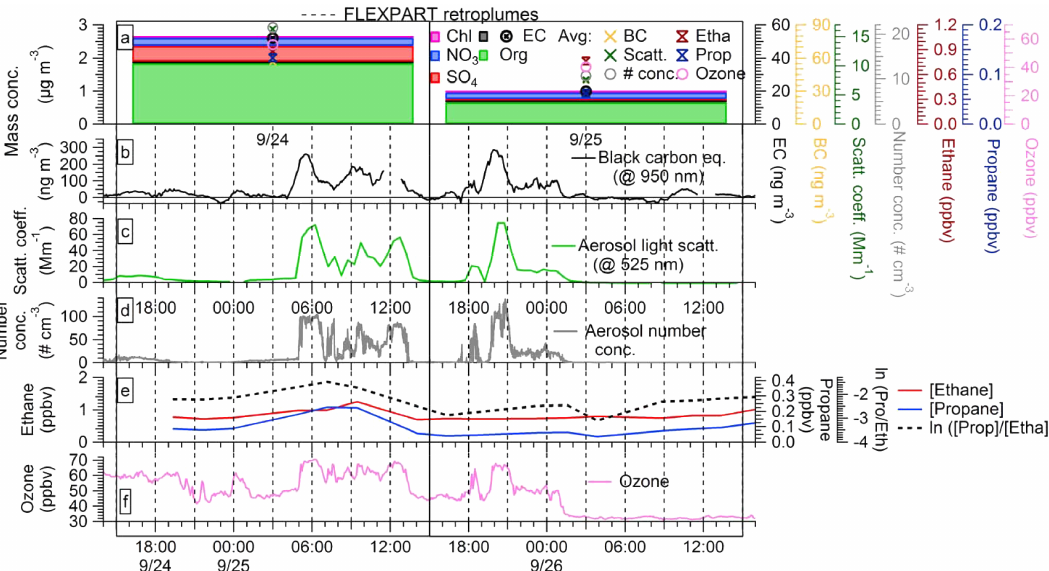
Figure 3. Comparison of aerosol measurements (a–d) during the 24–26 September case study with gas-phase measurements of ethane, propane (e) and ozone (f) . On-line measurements are also averaged during the filter-sampling periods (a) . Marked within the figure are the times of filter-collection periods (black rectangular shapes, as given in Table 1) and FLEXPART retroplume simulations (dashed lines, as shown in Figs. 2, S4 and S5). Times and dates are shown in the x axis of (d) and (f)